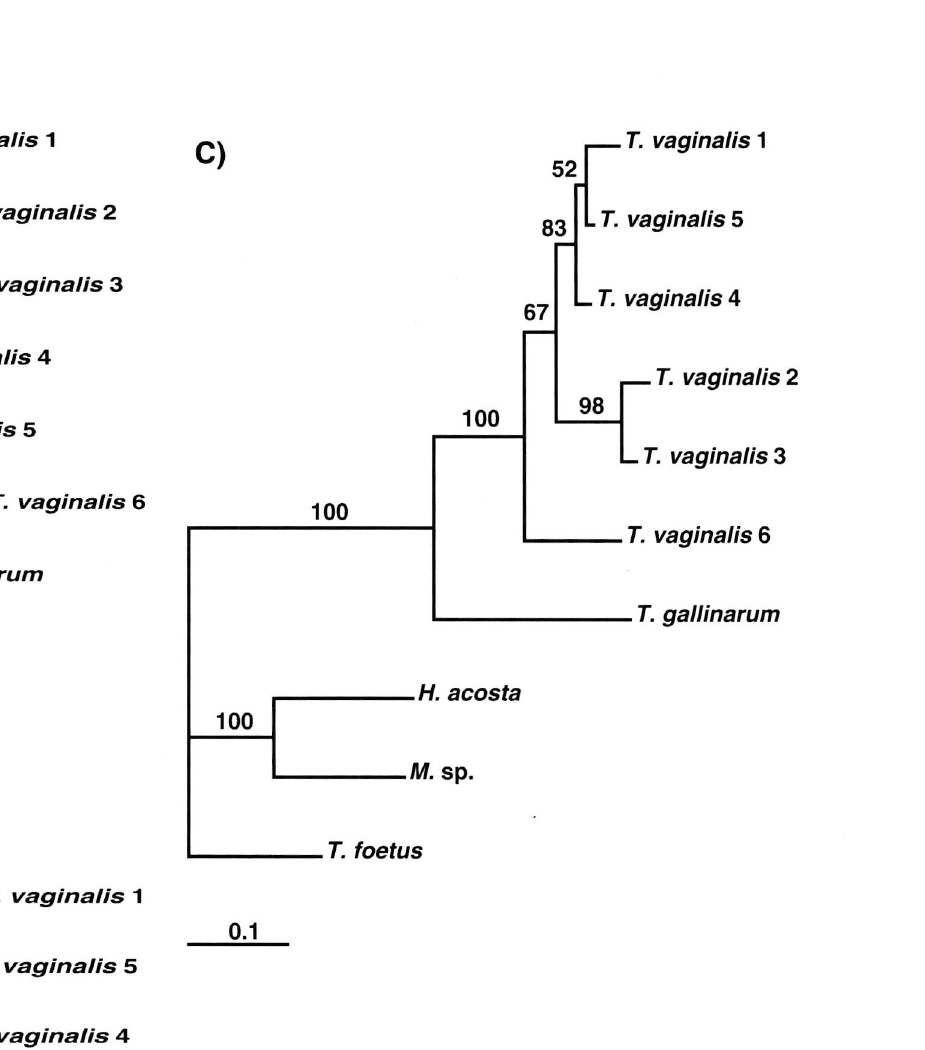
Fig. 2. - Phylogenetic relationships among six FeSOD types of Trichomonas vaginalis. (A) maximum parsimonious tree: tree length = 150 steps, CI = 0.7800, RI = 0.6413, and RC = 0.5002. Of 125 total characters (inputted alignment shown in Figure 1), 56 are constant and 46 are parsimony-informative characters. (B) neighbor joining tree: distance matrix measured by mean character difference was used for the NJ analysis. (C) maximum likelihood tree (Quartet puzzling tree): Dayhoff (Dayhoff etal., 1978) model was used as model of amino acid sequence substitution. Uniform rate of heterogeneity was assumed. Quartet puzzling was used to choose from the pos­ sible tree topologies and to simultaneously infer support values for internal branches. The numbers above or below branches indicate bootstrapping values (1,000 replications) in (A) and (B) and quartet puzzling values (1,000 puzzling steps). Scale bars correspond to (A) 10 steps, (B) 0.05 sub­ stitutions per amino acid, and (C) 0.1 substitutions per amino acid. Refer to the Figure 1 legend for the